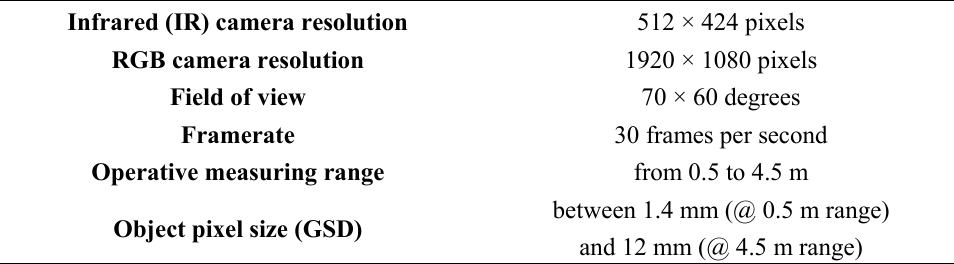
Table 1. Technical features of Kinect v2